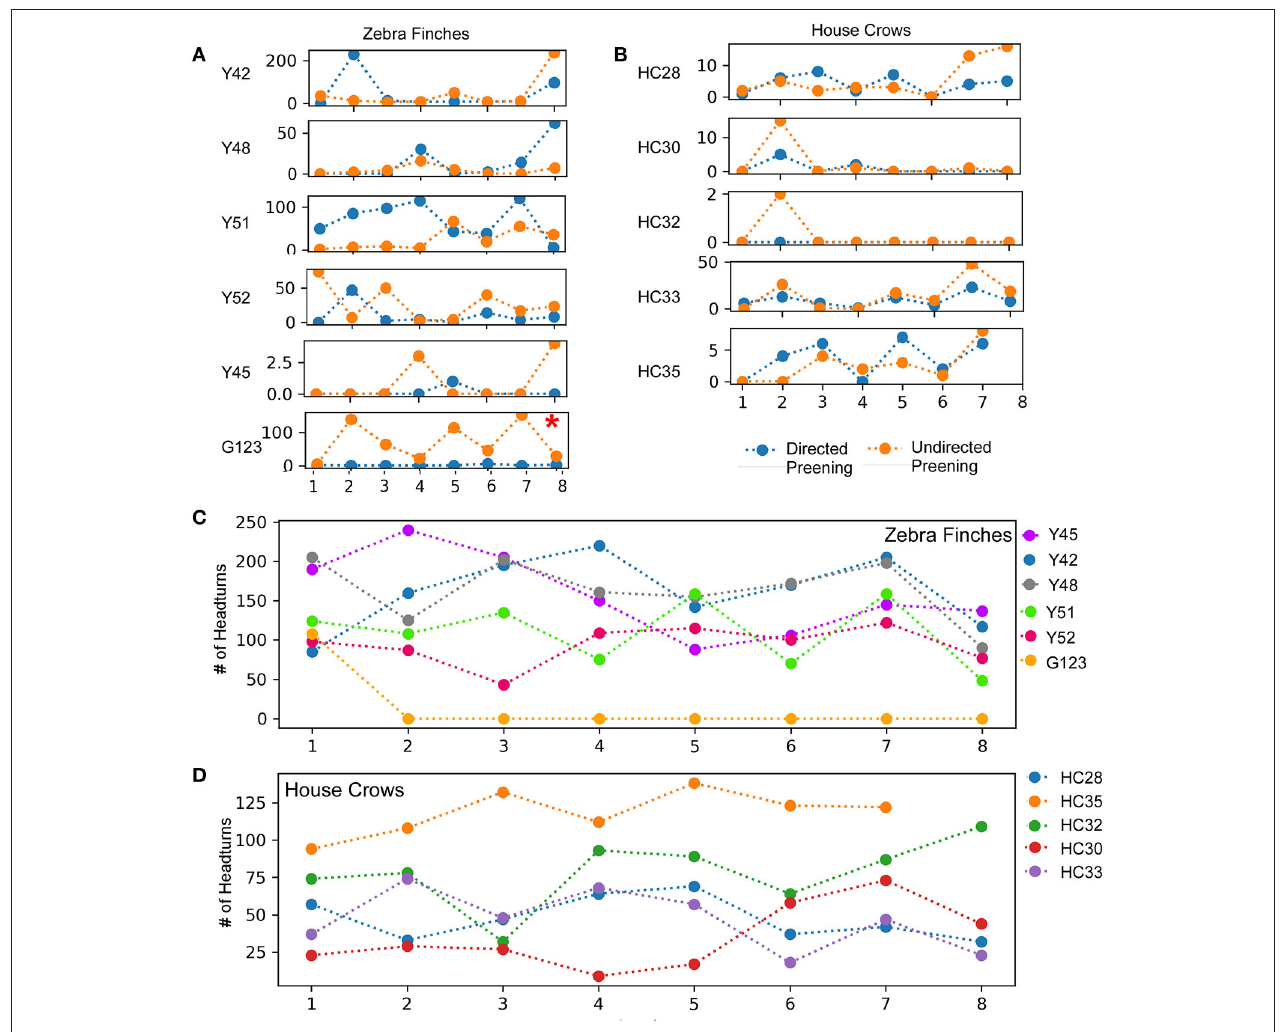
FIGURE 3 | A comparison of directed and undirected preening across successive mirror exposure trials for (A) zebra finches and (B) house crows. Blue dots and lines indicate directed preening whereas orange dots and lines indicate undirected preening ( t -test *, P < 0.05). The number of head turns in (C) zebra finches and (D) house crows during the mirror exposure phase did not change significantly across